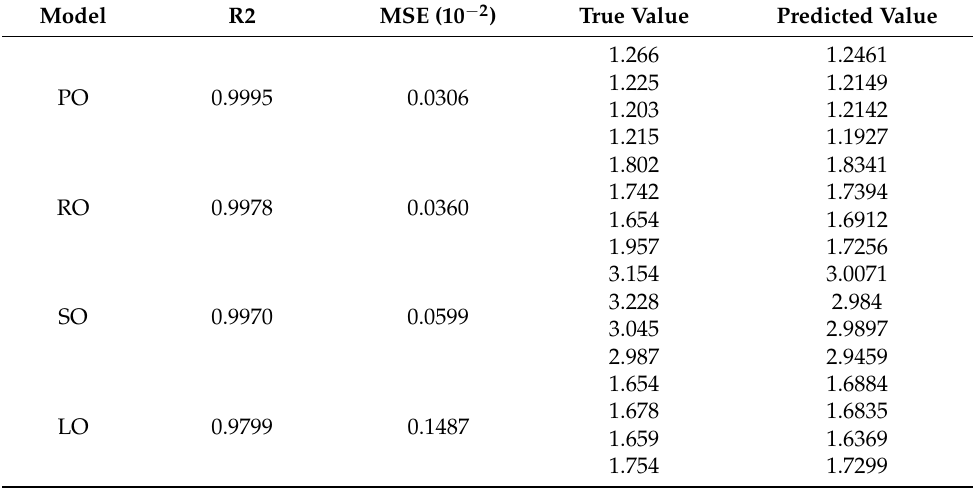
Table 5. Pearson correlation coefficient between free radical and input layer neurons of ANN in